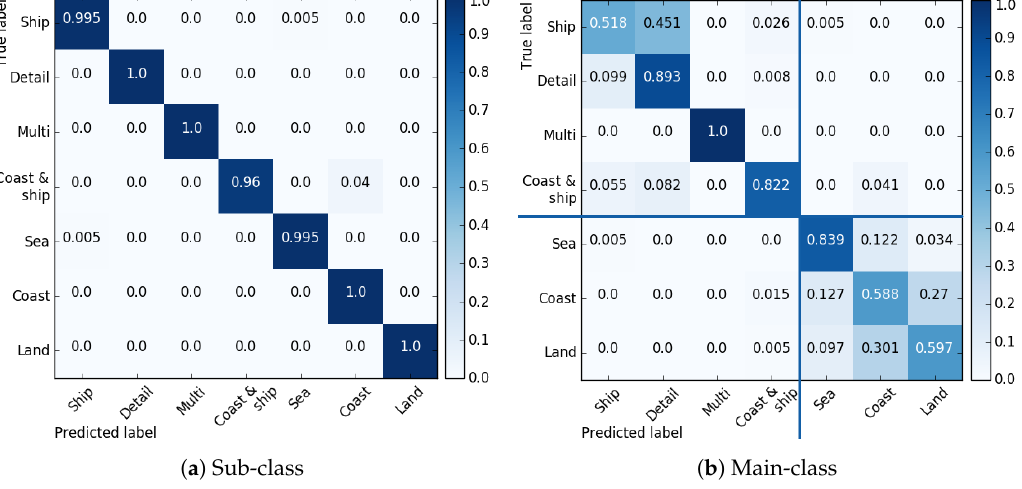
Figure 5. Normalized confusion matrices using sub-classes and main-classes. In the main-class matrix, two lines are drawn to separate the classes containing ships (Ship, Detail, Multi, and Coast & Ship) from those that do not have them (Sea, Coast and